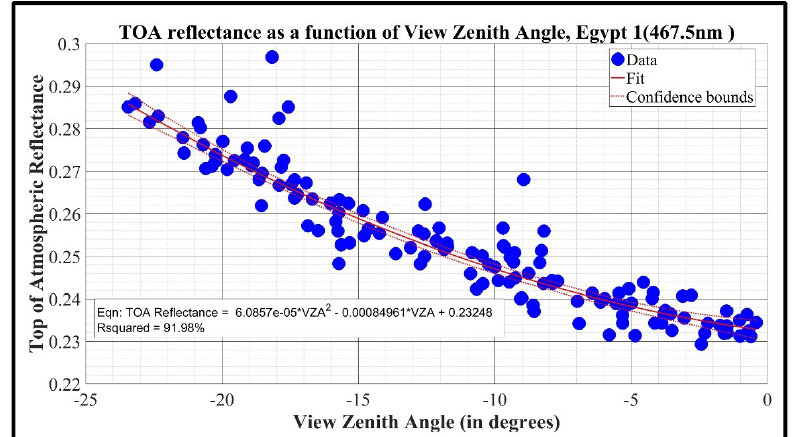
Figure 4. Quadratic BRDF correction Model of Egypt 1 based on view zenith angle.